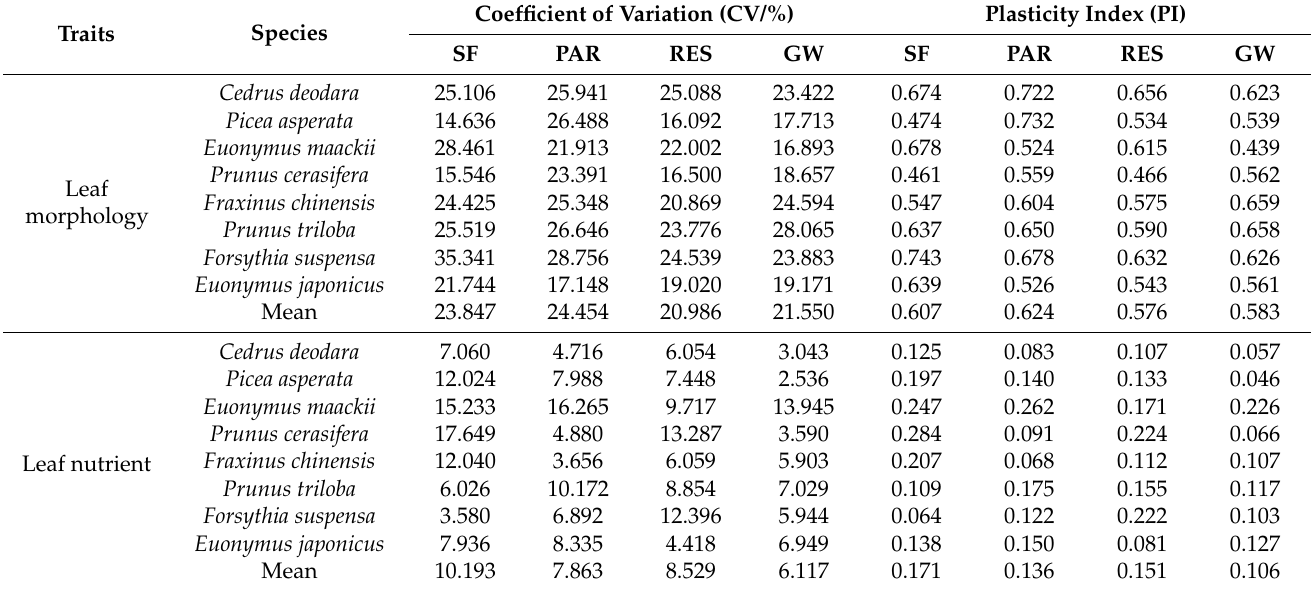
Table 4. Coefficient of variation and plasticity index of leaf morphology and leaf nutrient traits of eight garden plants in four green space environments. SF = sport field; PAR = park; RES = residential green space; GW =